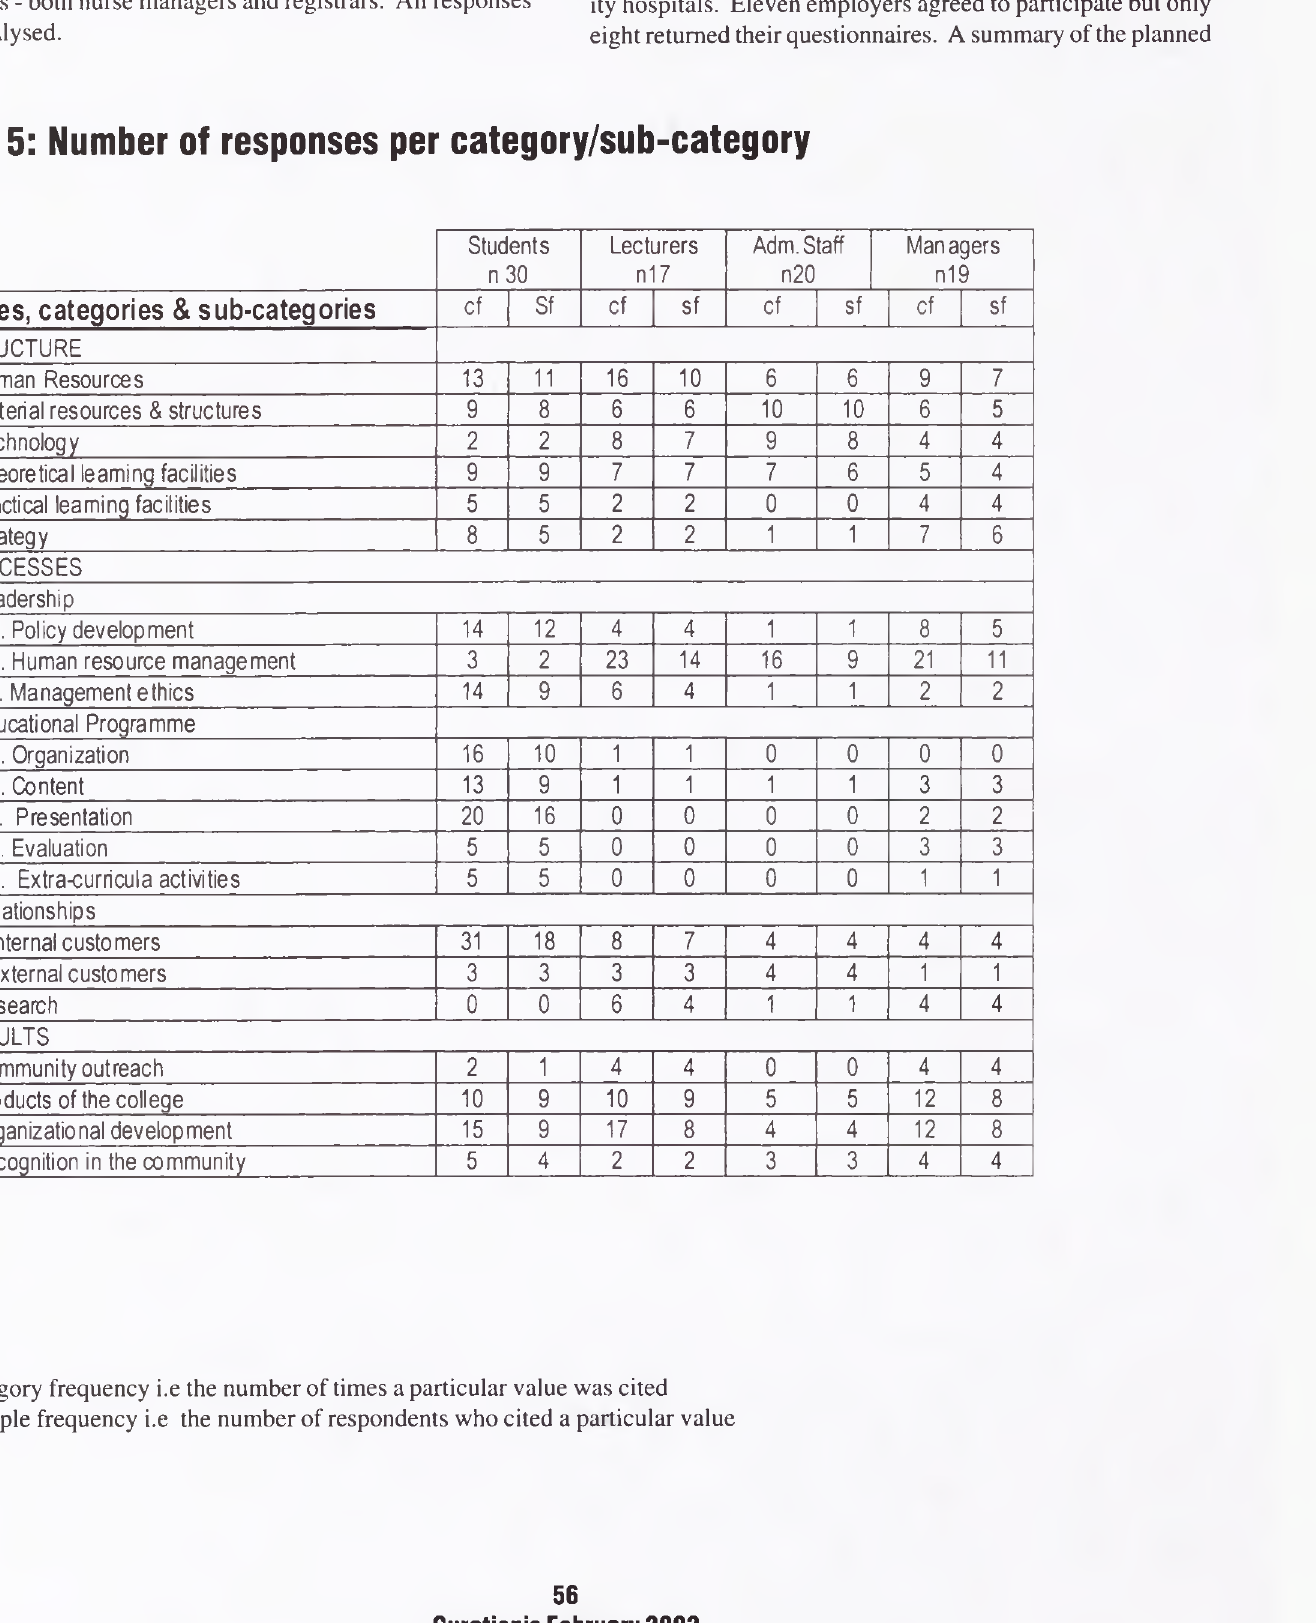
Table 5: Number of responses per